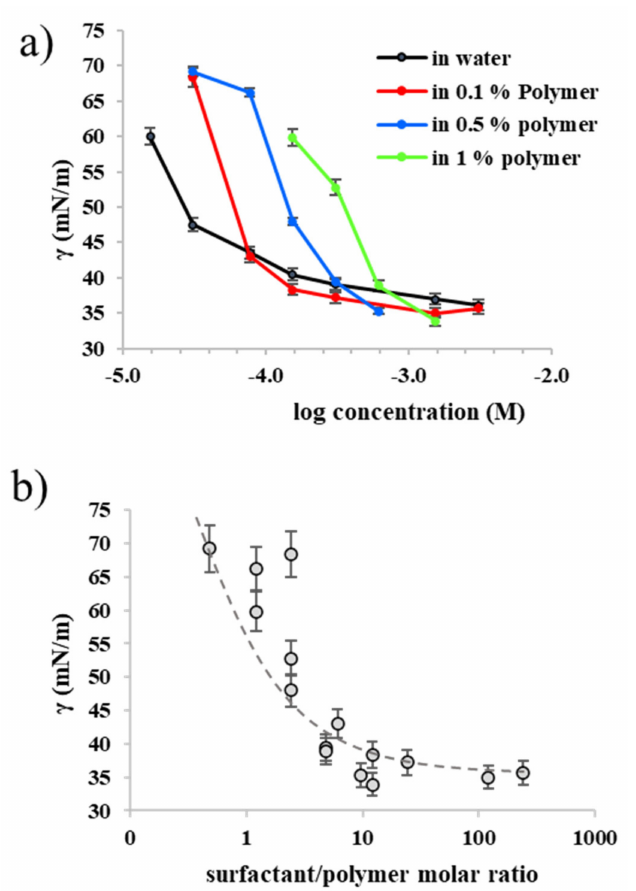
Figure 3. ( a ) surface tension curve of Enordet at different polymer concentrations; ( b ) master curve of surface tension as a function of the surfactant/polymer ratio. The dotted line is intended as a guide for the